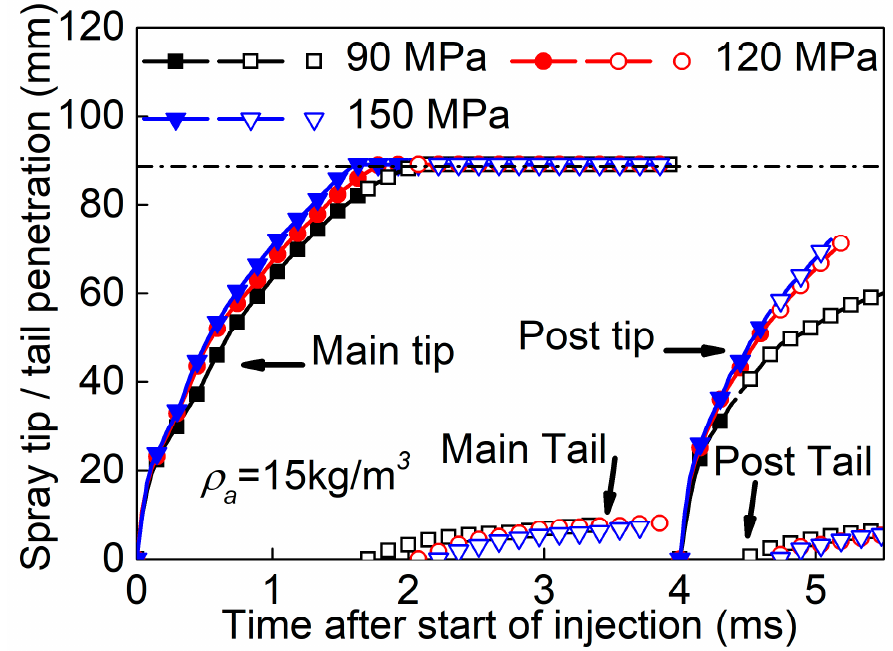
Figure 11. Results of spray tip and tail penetrations when applying the main-post injection strategy under various injection pressures.